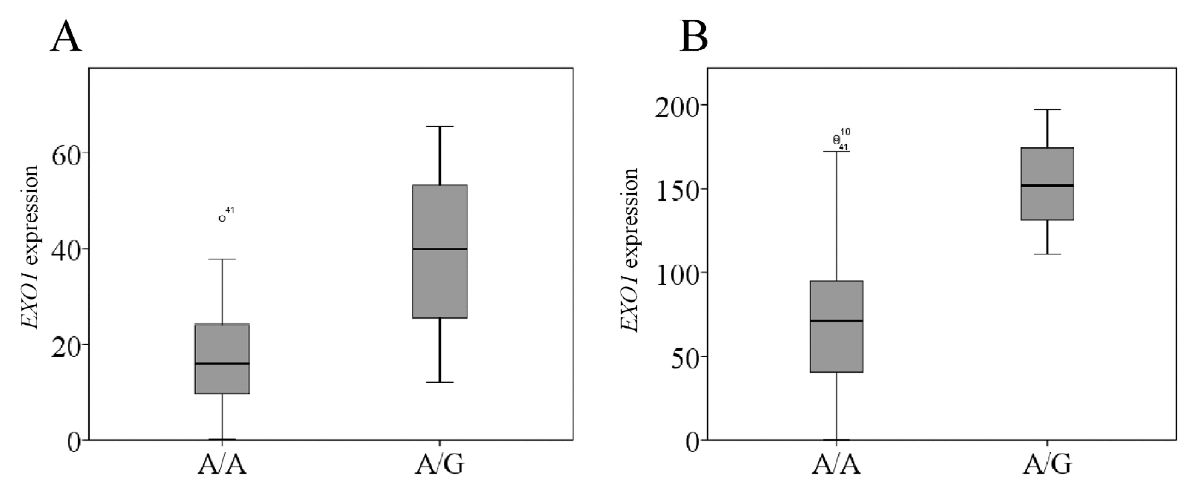
Figure 3 – Relationship between rs72755295 genotype and EXO1 expression in LCL at CEU population from literature Jadhav et al. (2019) (A) and Montgomery et al . (2010) (B). The expression is displayed as FPKM.